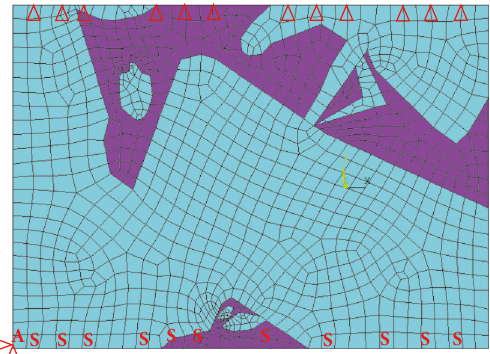
Figure 6: Mesoscale finite element model of the